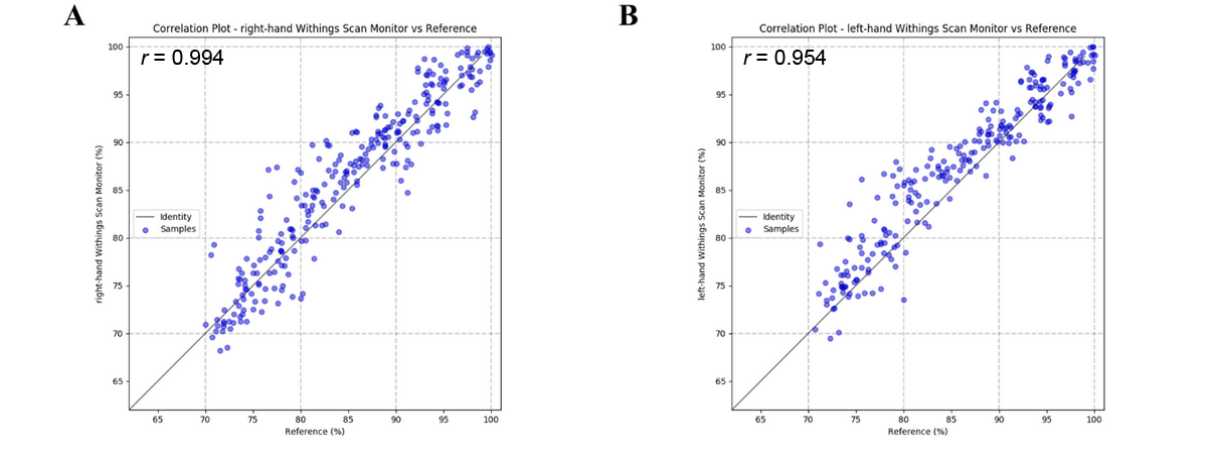
Figure 4. Correlation plots for the Withings ScanWatches versus the ABL90 hemoximeter from the participants’right (A) and left (B) hands.